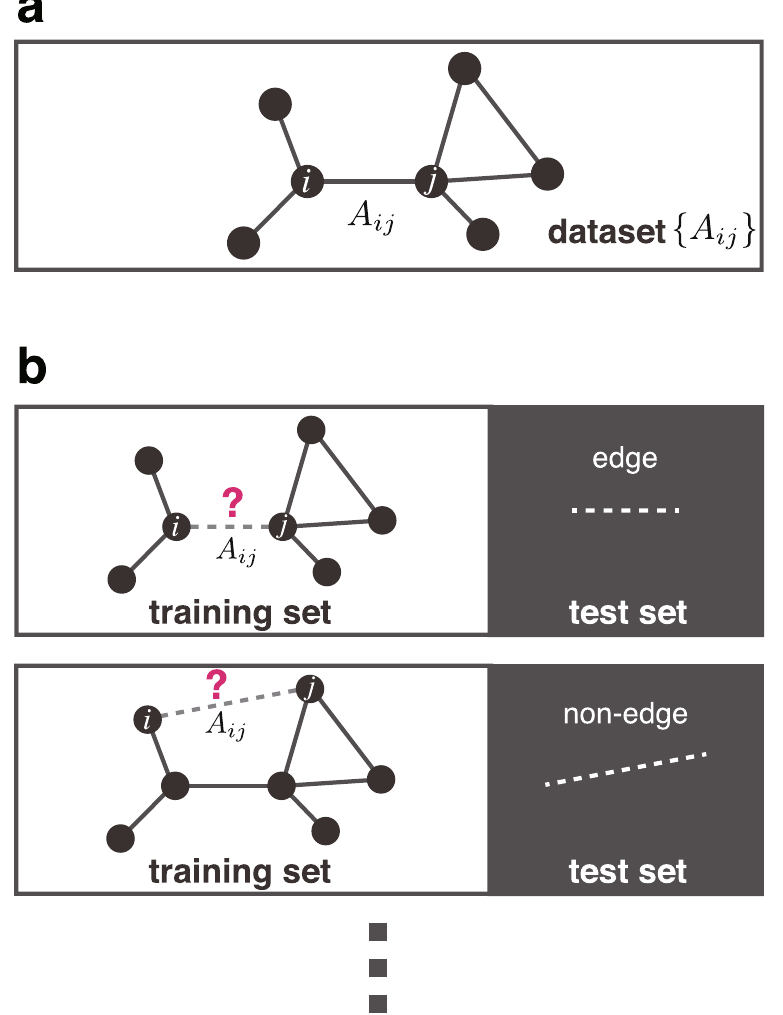
Figure 2. The LOOCV error estimate of the network data. ( a ) The original dataset is given as the adjacency matrix A of a network. ( b ) In each prediction, we hide a single piece of edge or non-edge information from A : this unobserved edge or unobserved non-edge is the test set, and the adjacency matrix A i j \( , ) without the information on that edge or non-edge is the training